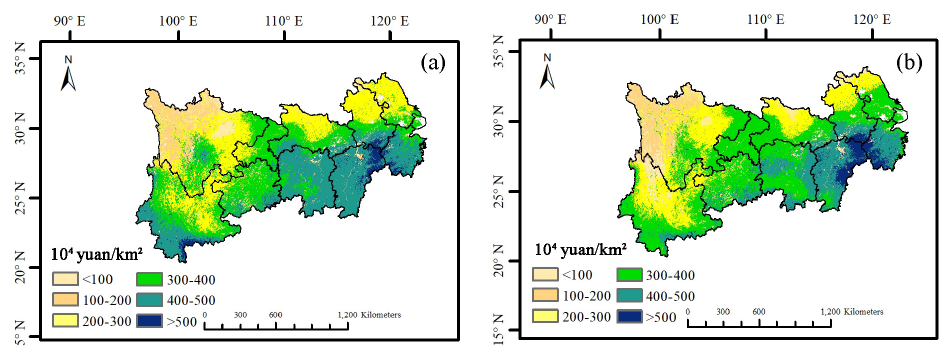
Figure 6. Spatial characteristics of integrated ESV in the YREB from 1999 to 2018 (( a ): 1999–2008; ( b ): 2009–2018).